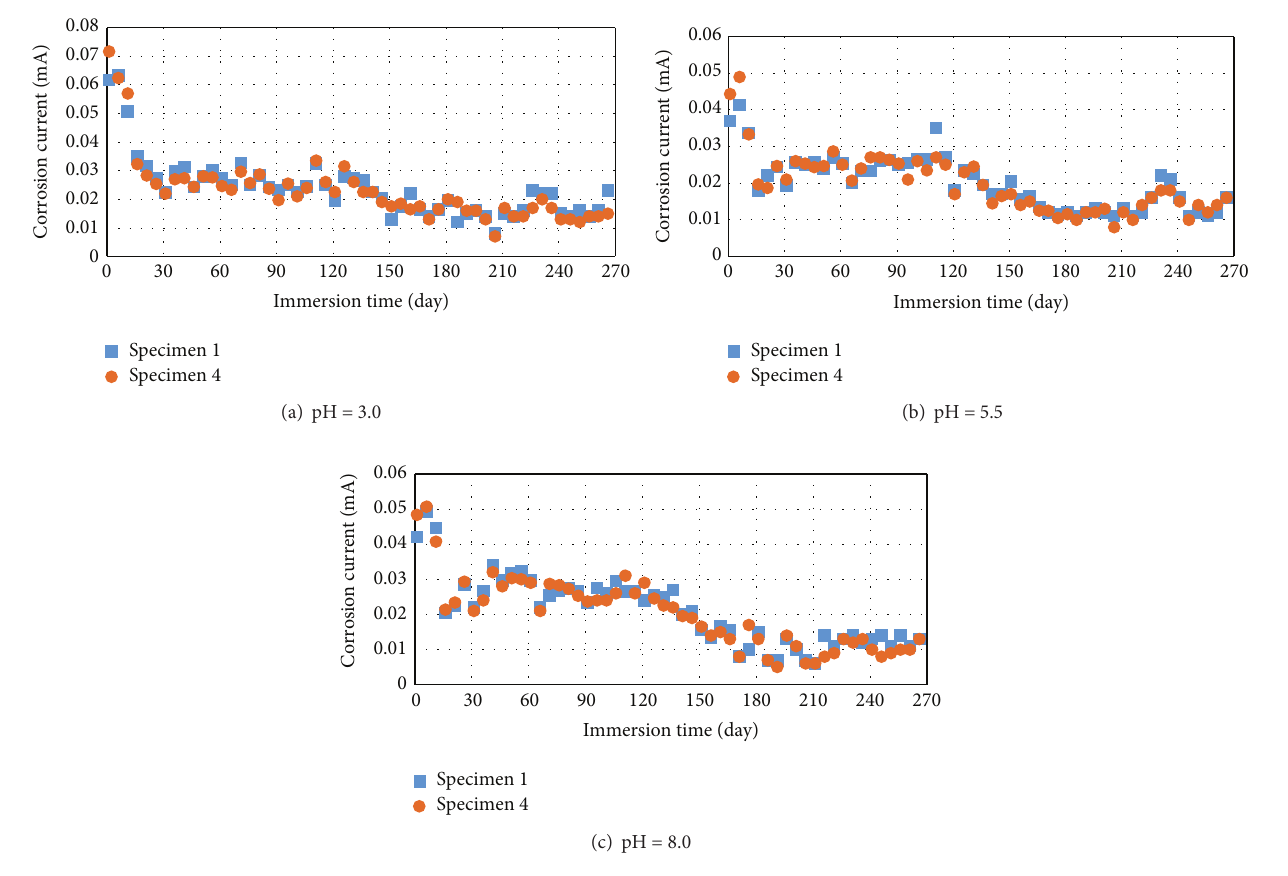
Figure 5: Corrosion current in steel specimens in solutions of different pH